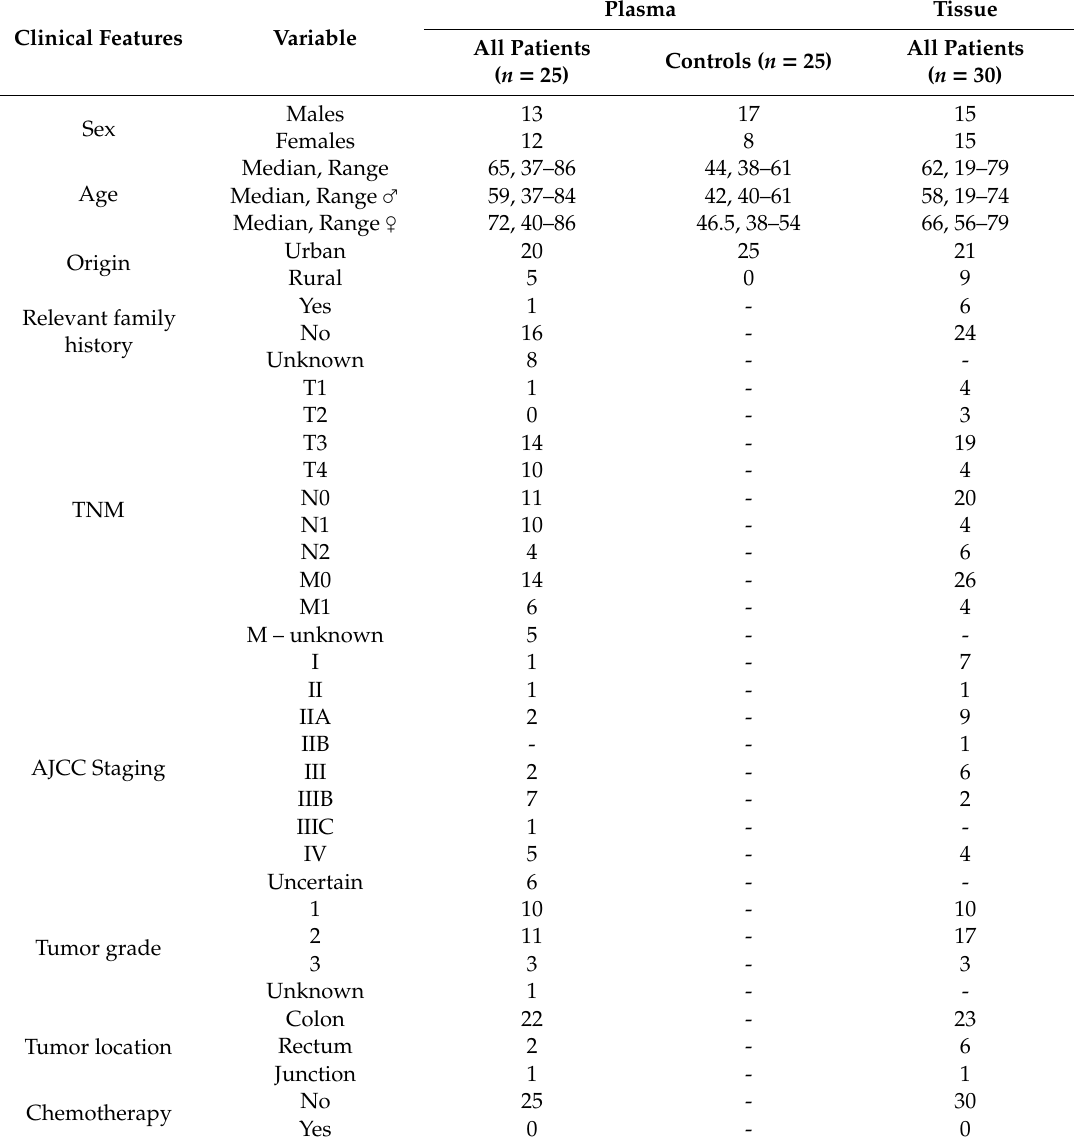
Table 3. Clinical data for the patients used for qRT-PCR, representing 24 colorectal plasma samples, 25 healthy controls and 30 matched paired tumor–normal tissue